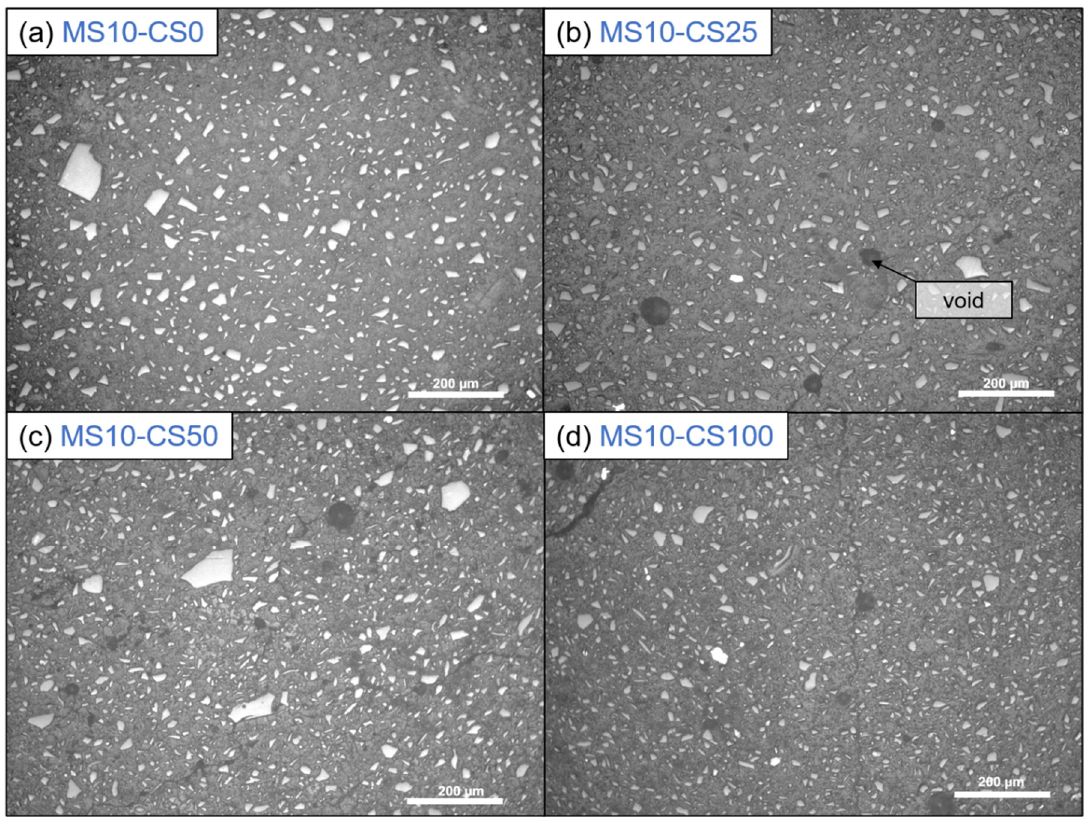
Figure 11. Optical microscopy with incident light of 10 wt% metasilicate systems. Slag composition varies from ( a ) composition 2: MS10-CS0, 100 wt% GGBS, ( b ) composition 9: MS10-CS25, 75 wt% GGBS, 25 wt% CS, ( c ) composition 8: MS10-CS50, 50 wt% GGBS, 50 wt% CS to ( d ) composition 5: MS10-CS100, 100 wt% CS. Dark gray bubbles are voids. (See Table 2 for mix design).